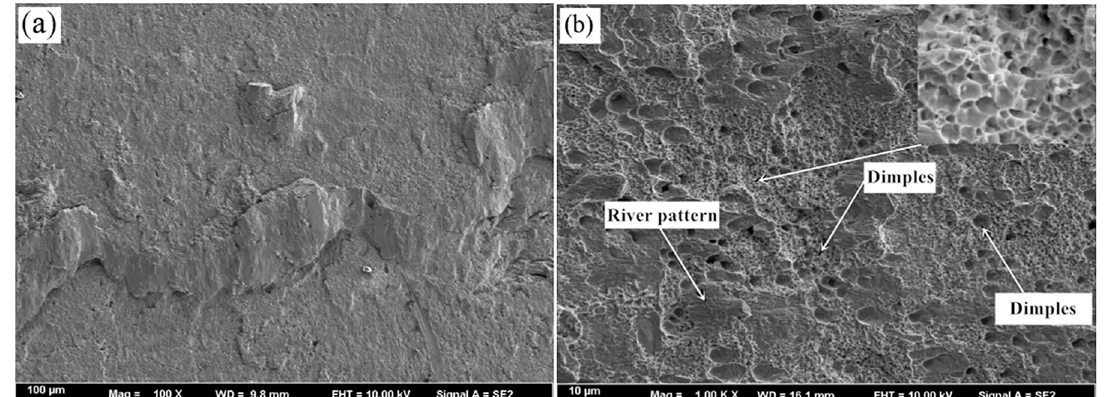
Figure 11. Fracture morphology of the brazed joint. Finally, Brazed joint could be divided into two distinct declined, γ-Ni solid solution were unable to contain excessive zones: ISZ and DAZ. ISZ consisted of γ-Ni solid solution Si, and Si precipitated in form of Ni Si grains during cooling 3 formed by complete isothermal solidification, which stage, surrounding γ-Ni solid solution and playing a role in precipitation strength.